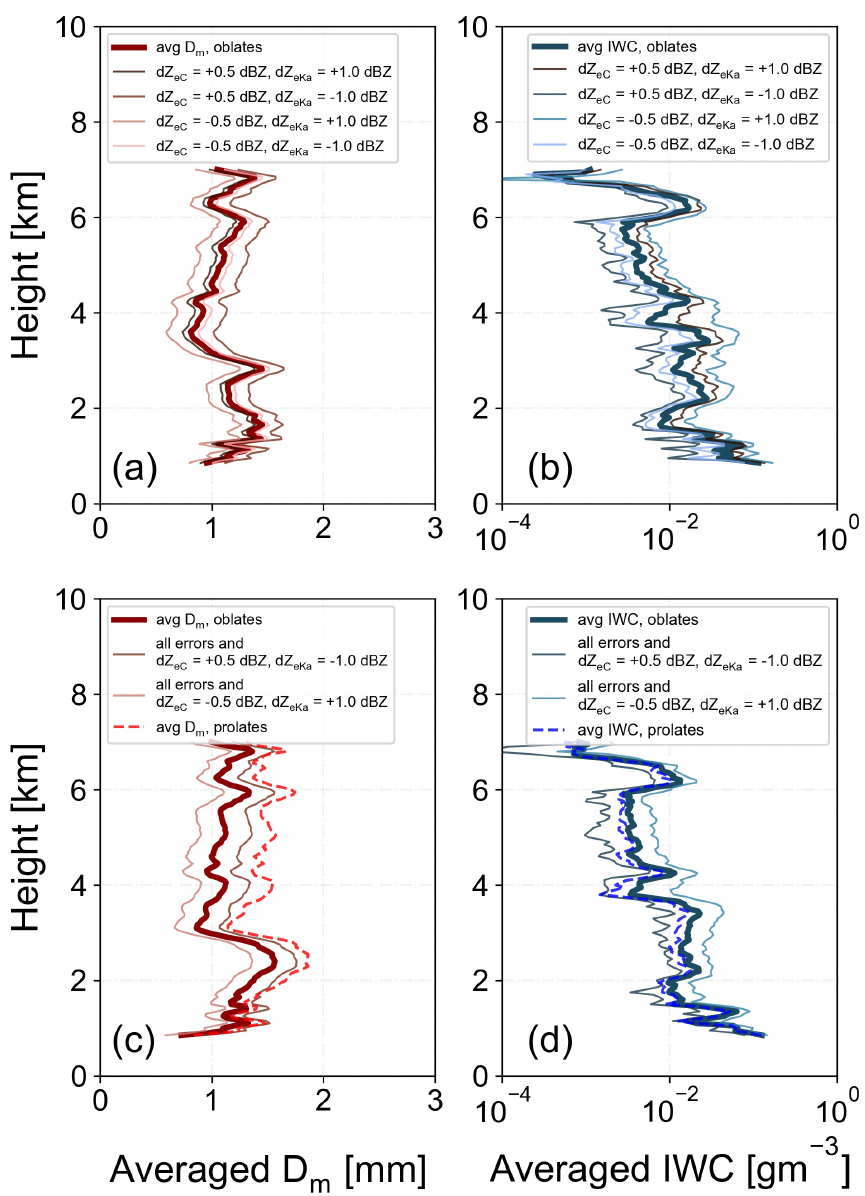
Figure 13. Averaged profiles of the retrieved (a) D m and (b) IWC as derived from Fig. 11b and d for oblate ice spheroids, with (thinner lines) and without (thicker line) considering the calibration error for both radars. (c, d) Same as (a, b) but now the beam width error, the spatiotemporal error, and dDWR = + 0 . 5dB or dDWR = − 0 . 5dB are considered. With dashed lines the retrieved D m and IWC as derived from Fig. 12b and d for the horizontally aligned prolate assumption are plotted. All panels refer to the case study from 30 January 2019 at 10:08UTC as well as to aggregate mass–size relationship and exponential particle size